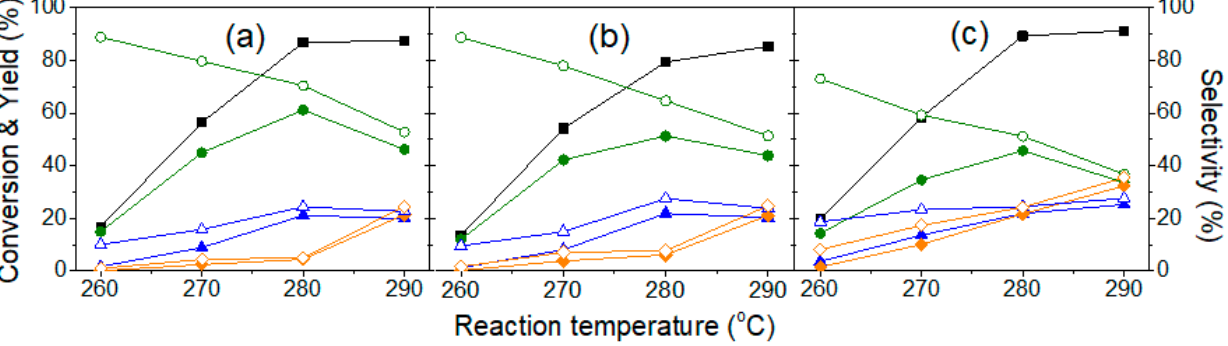
Figure 5. The influence of the reaction temperature on the etherification reaction of glycerol: ( a ) XZ-Li, ( b ) XZ-Na and ( c ) XZ-K (- ■ -: conversion of glycerol, - ● -: yield of DG, - ▲ -: yield of TG, - ♦ -: yield of others - ○ -: selectivity of DG, - Δ -: selectivity of TG, - -: selectivity of others, amount of zeolite: 3 wt.%, reaction time: 2 h).